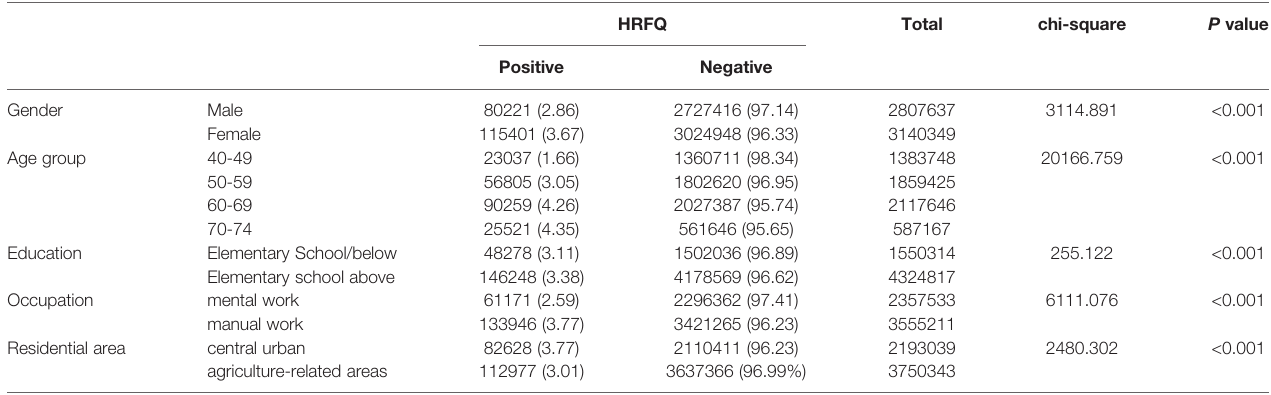
TABLE 2 | Comparison of positive HRFQ for different CRC screening population subgroups (2012-2020), (n, %).